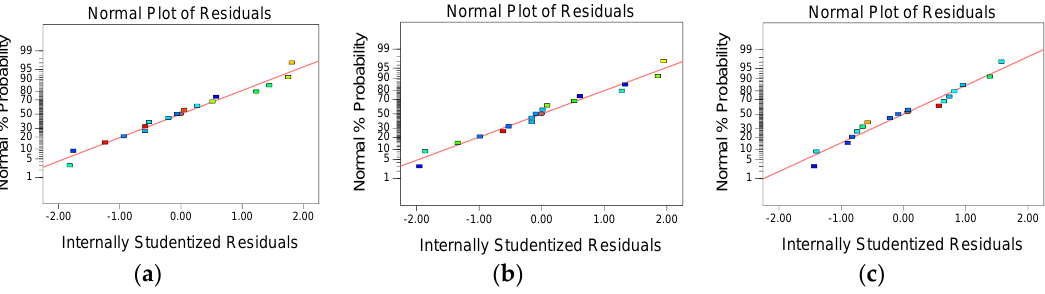
Figure 1. Normal plot of residuals: ( a ) absorbance; ( b ) TP concentration; and ( c ) TAN concentration.